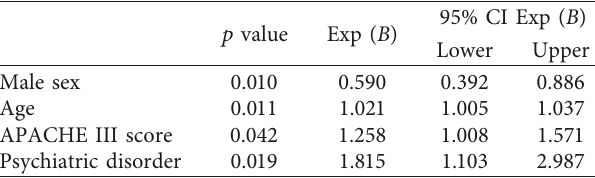
Figure 2: Kaplan–Meier survival analysis for patients with and without delirium during ICU stay. Table 5: Binary multiple regression